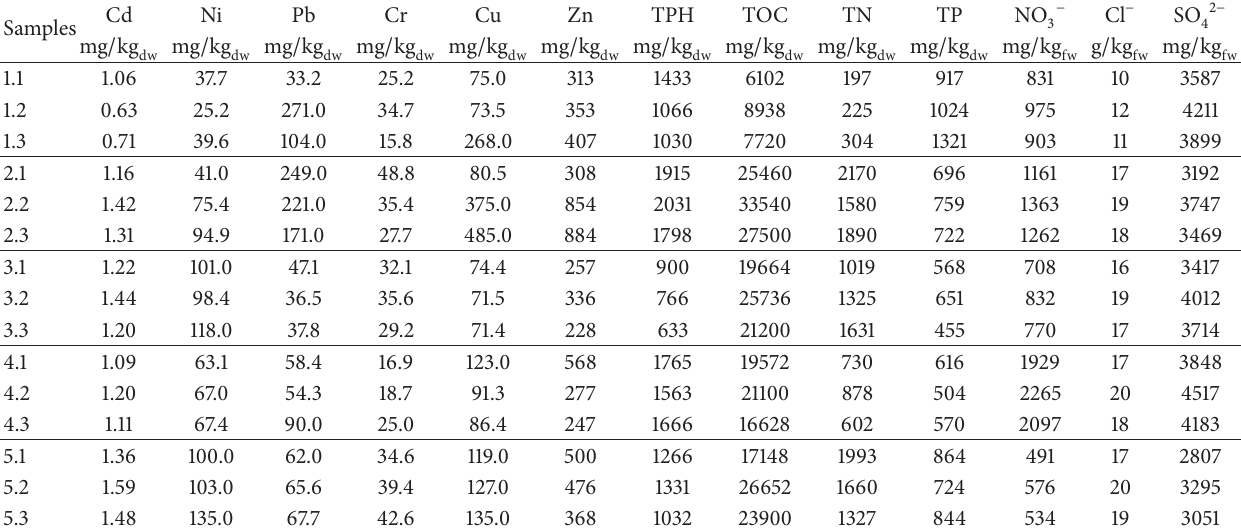
Table 1: Chemical parameters of the five sampling sites